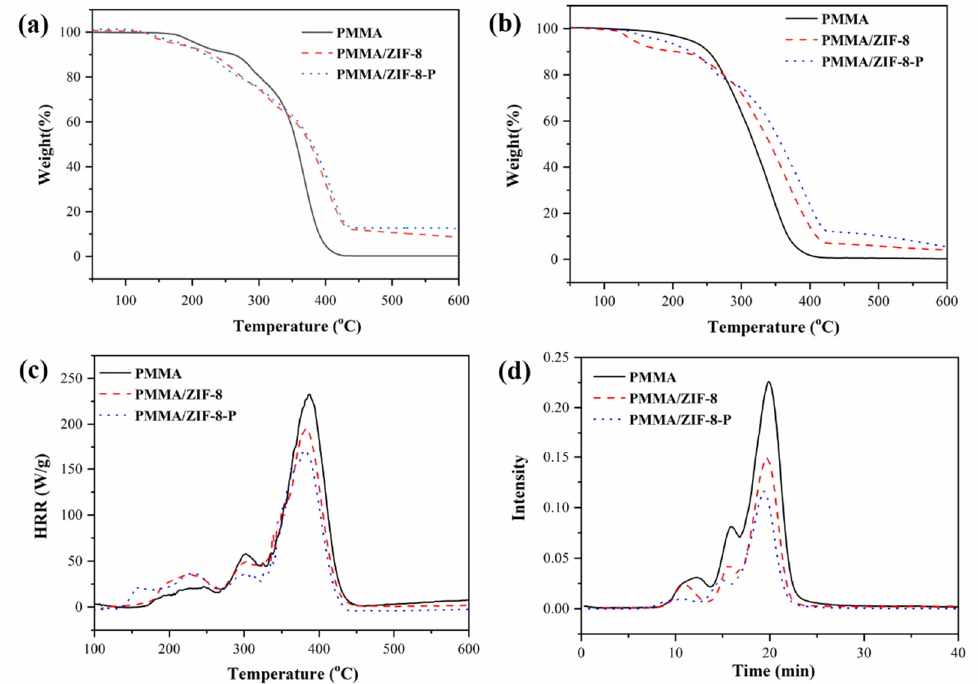
Figure 3. Thermogravimetric analysis (TGA) curves of PMMA, PMMA/ZIF-8, and PMMA/ZIF-8-P composites under ( a ) nitrogen and ( b ) air atmospheres at a heating rate of 20 °C/min. ( c ) Heat release rates (HRRs), along with the temperatures of the PMMA, PMMA/ZIF-8, and PMMA/ZIF-8-P composites in the microscale combustion calorimeter (MCC) test. ( d ) Intensity of total released gas during thermal degradation process of pure PMMA, PMMA/ZIF-8, and PMMA/ZIF-8-P composites in a nitrogen atmosphere with a heating rate of 10 °C/min.